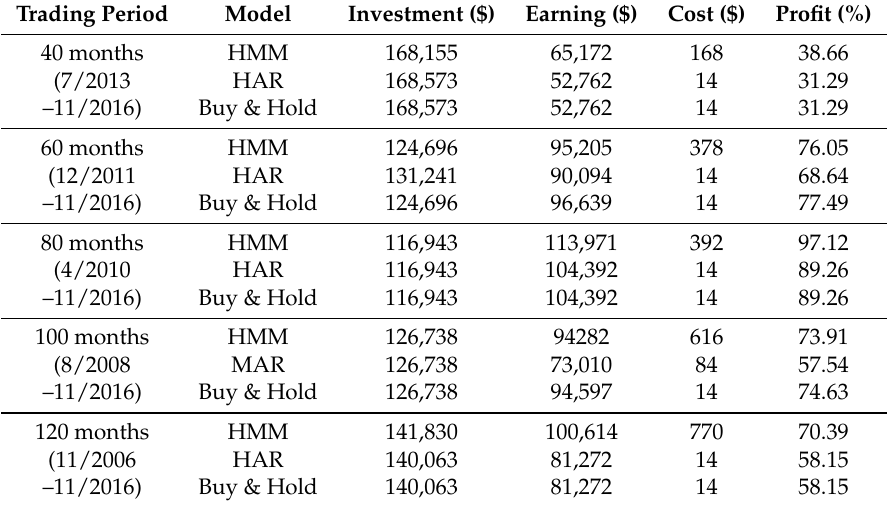
Table 5. S&P 500 trading using the HMM, HAR, and Buy & Hold models for different time periods. Trading